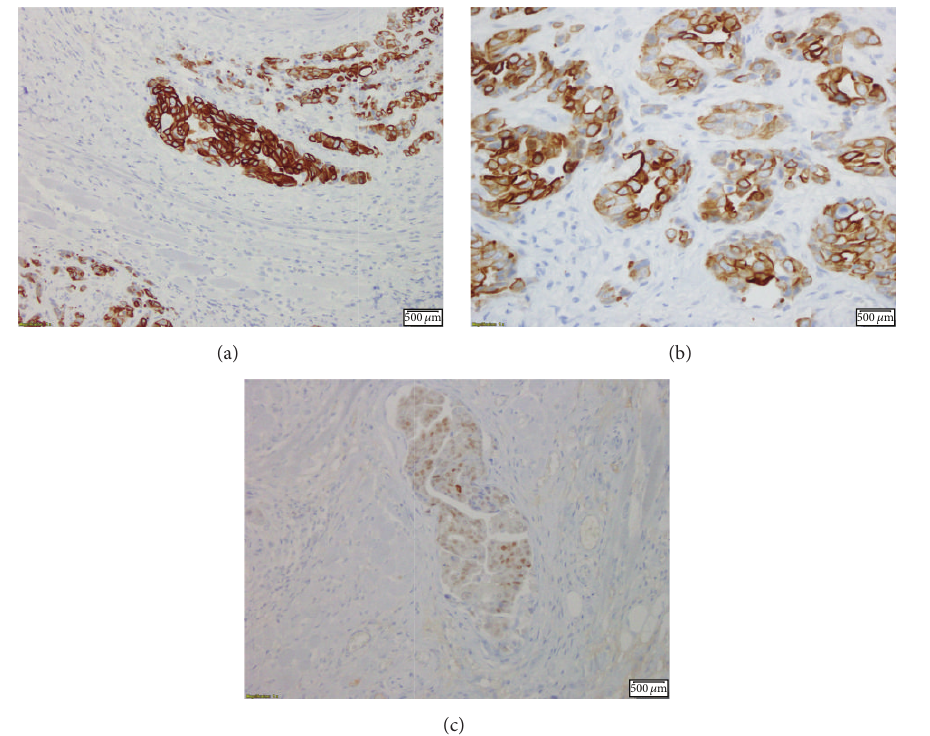
Figure 3: IHC stain showing cytokeratin 20 (a and b) and CDx-2 (c) positivity, markers normally associated with gastrointestinal malignancies.